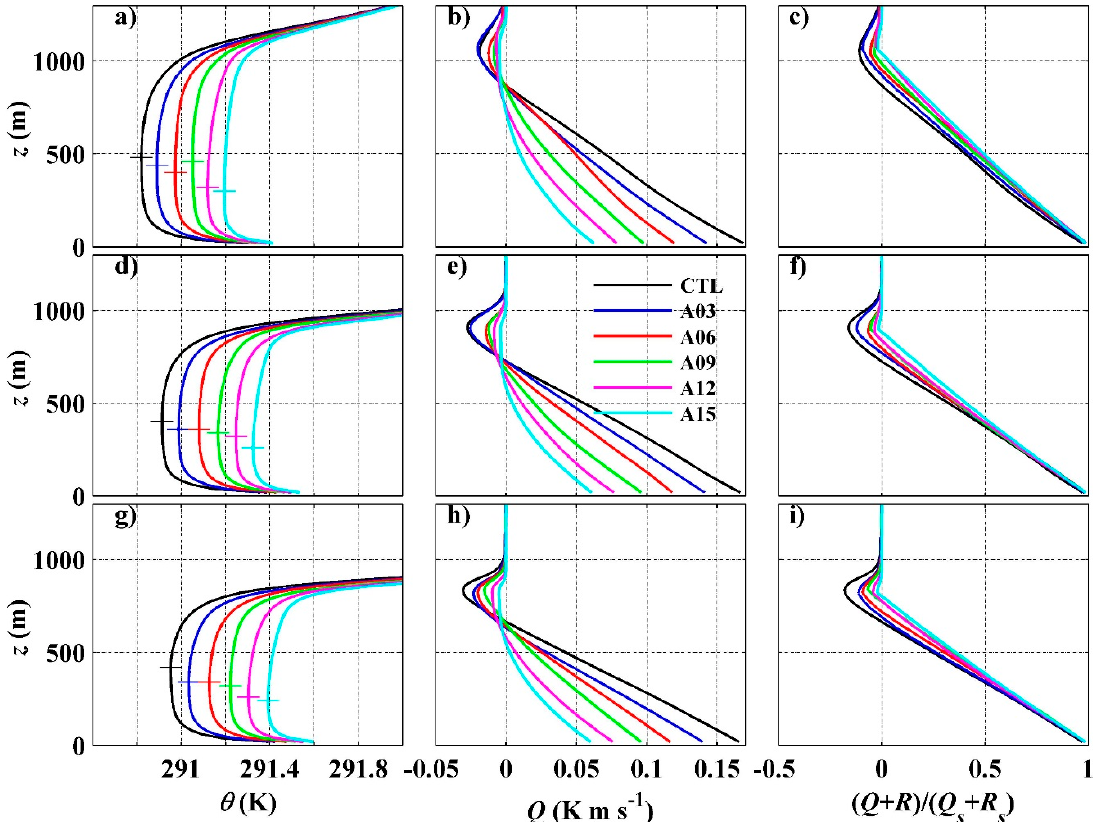
Figure 8. Vertical profiles of potential temperature (left column, a , d , g ), vertical kinematic turbulent heat flux (central column, b , e , h ), and total heat flux (right column, c , f , i ) for the cases with three different stratification strengths in the free atmosphere: 3 K km − 1 (upper row, a,b,c), 6 K km − 1 (middle row, d,e,f), and 9 K km − 1 (lower row, g,h,i). Black: CTL, AOD = 0; blue: A03, AOD = 0.3; red: A06, AOD = 0.6; green: A09, AOD = 0.9; magenta: A12, AOD = 1.2; cyan: A15, AOD = 1.5. The short horizontal dash indicates the position of zero mean θ gradient. Q: turbulent kinematic heat flux; R: shortwave radiation flux; Q s : surface heat flux; R s : surface downward shortwave radiation